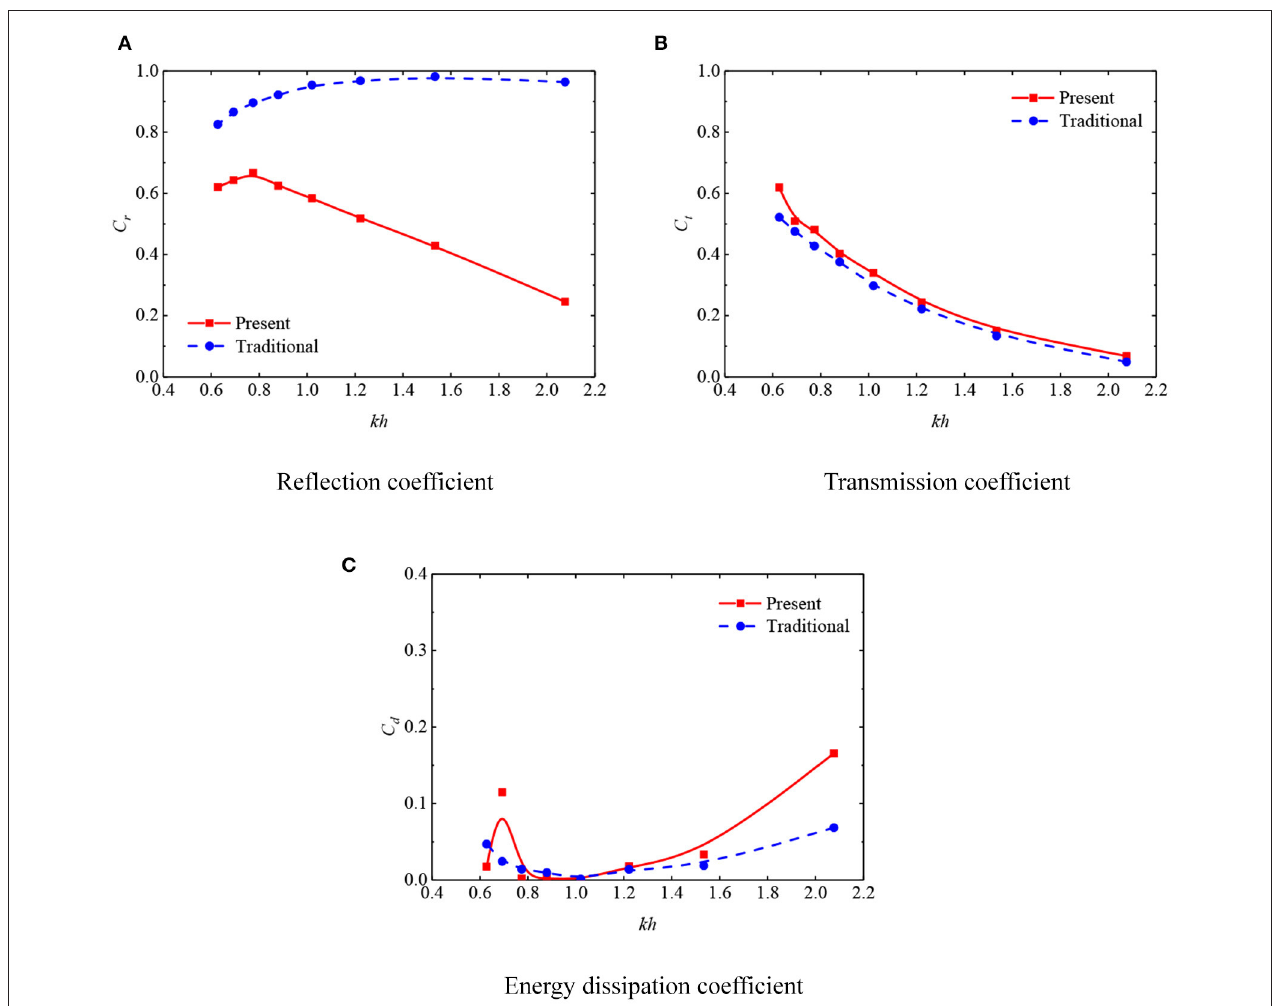
FIGURE 10 | Hydrodynamic coefficients of oscillating water column (OWC) device and traditional breakwater with three incident wave heights for d 2 = 7.5 d 1 , B = 2.5 a . (A) Reflection coefficient. (B) Transmission coefficient. (C) Energy dissipation coefficient.